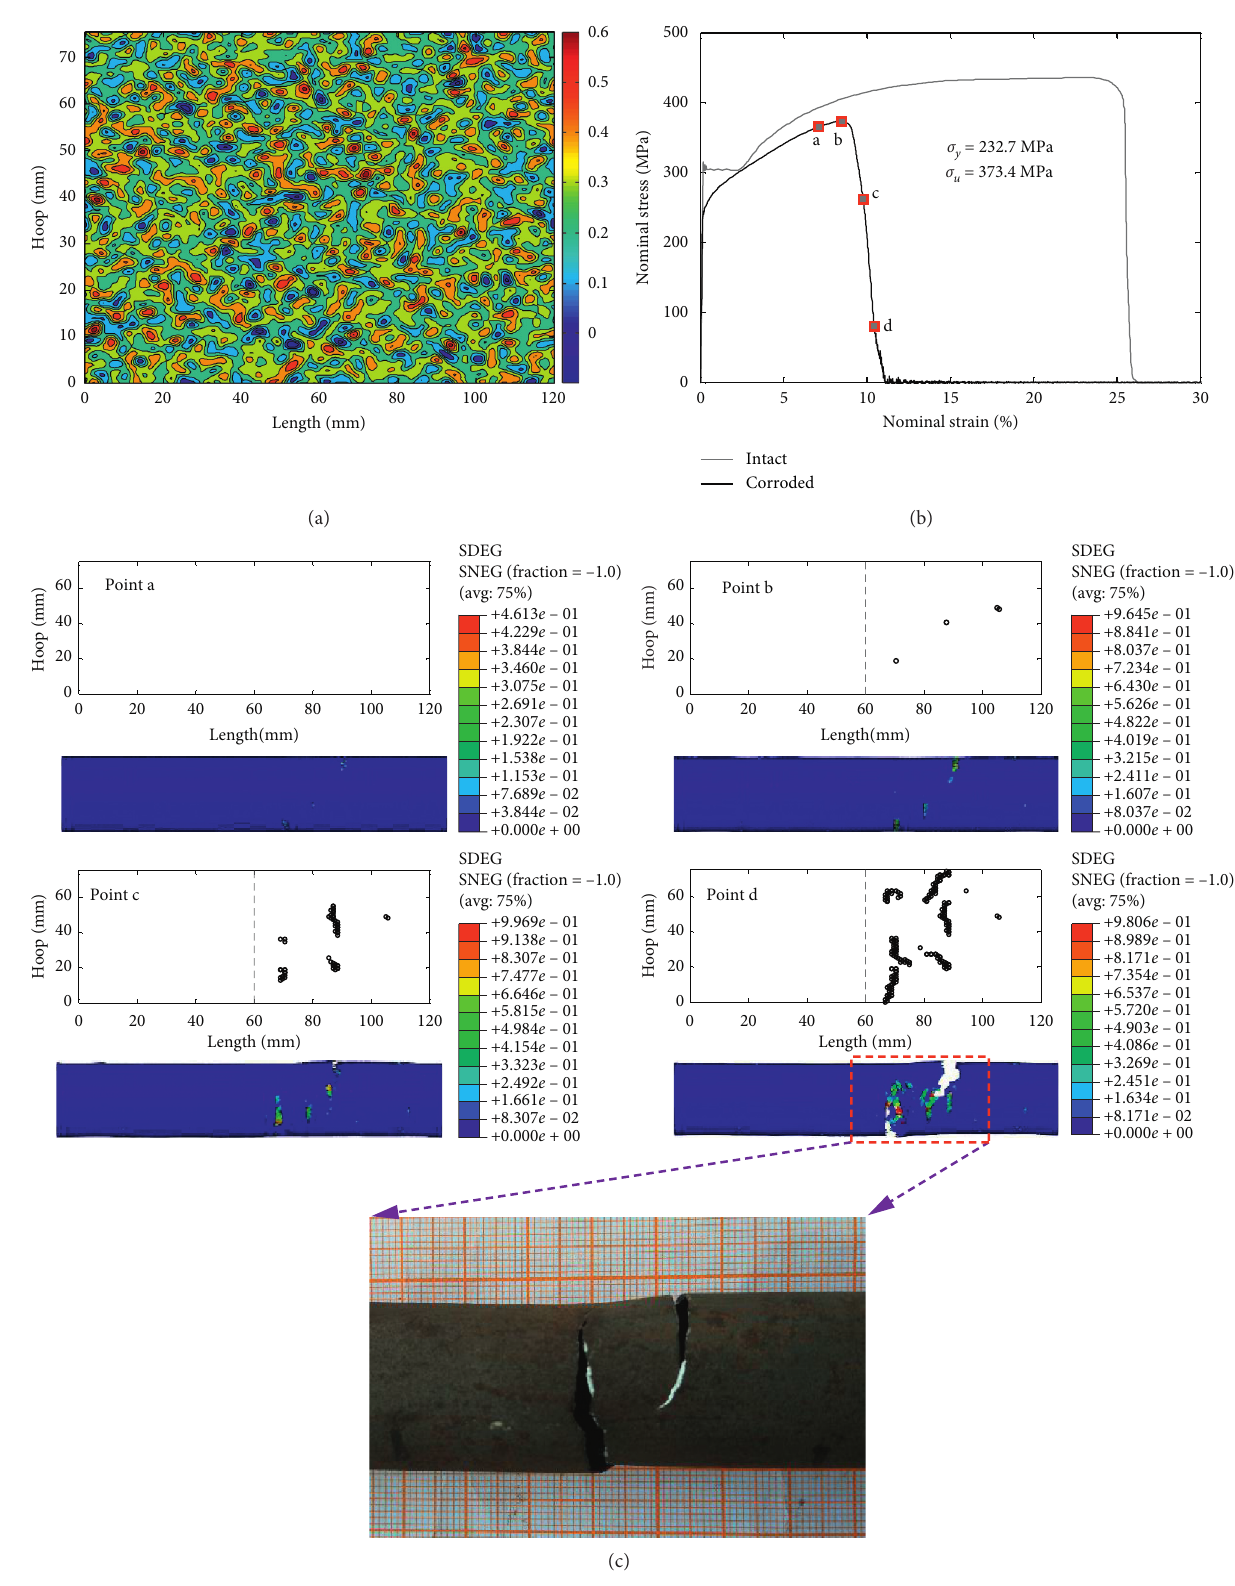
Figure 10: Damage evolution and fracture mode of a corroded pipe. (a) Random field with a value of η � 70% and δ � 0 . 10 mm, (b) stress- strain curve, (c) crack propagation at points marked in (b) and crack observed in test specimen with η � 71 .